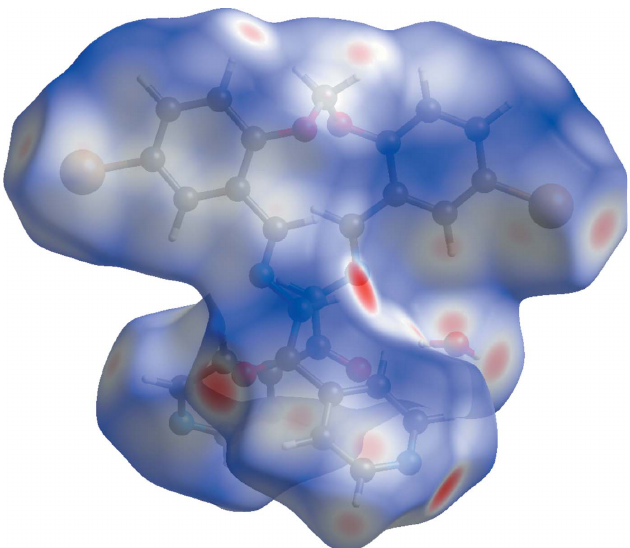
Figure 5 The Hirshfeld surfaces of compound (I), mapped over d norm ; fixed colour scale of (cid:5) 0.512 (red) to 1.285 (blue) arbitrary units.